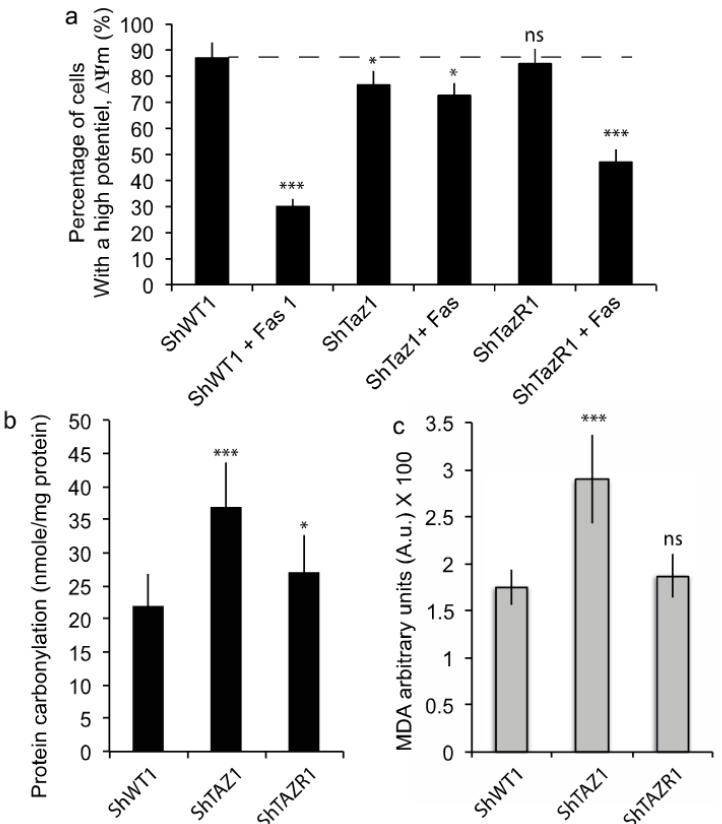
Figure 2. Biochemical characterization of Fas-induced apoptosis and the oxidative cellular context. ( a ) Fas-induced apoptosis is inhibited in ShTaz1 RNAi knockdown cells and the cell death process is restored in the revertant cells (ShTaz1R cells). The ± SEM is related to seven independent preparations. ( b ) Protein carbonylation measurements for ShWT1, ShTaz1 and ShTazR1 cells. ( c ) Malonaldehyde product ion measurements for ShWT1, ShTaz1 and ShTazR1 cells. ns = no significant and * is the p -value ≤ 0.05 and *** is the p -value ≤